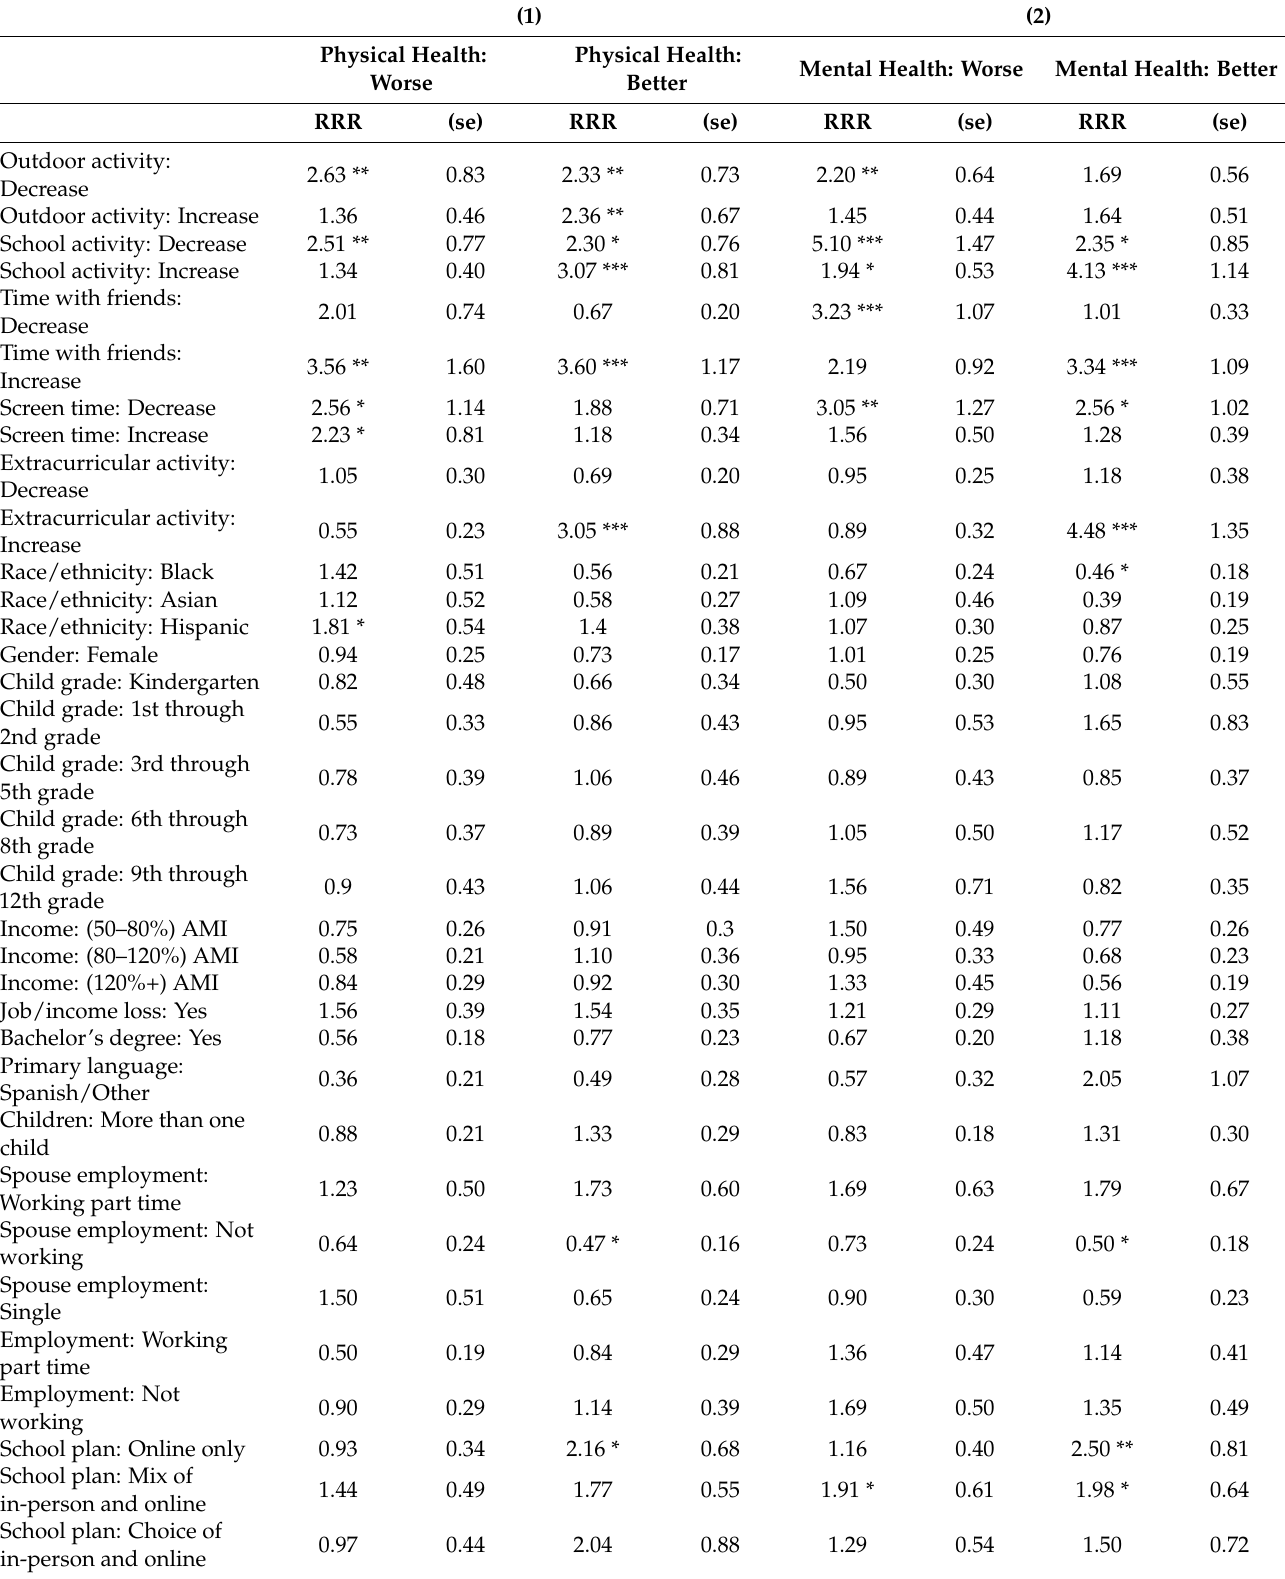
Table 2. Association of changes in child and adolescent activities with changes in physical and mental health during COVID-19. (1)